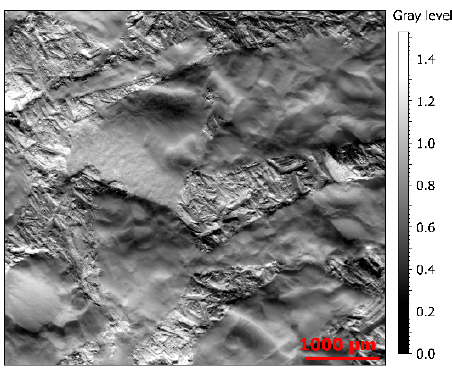
Figure 1. Rendering of Y-gradients (slopes) of a measurement on surface from material 3 (Section 2.2) (5140 × 4797 μ m).